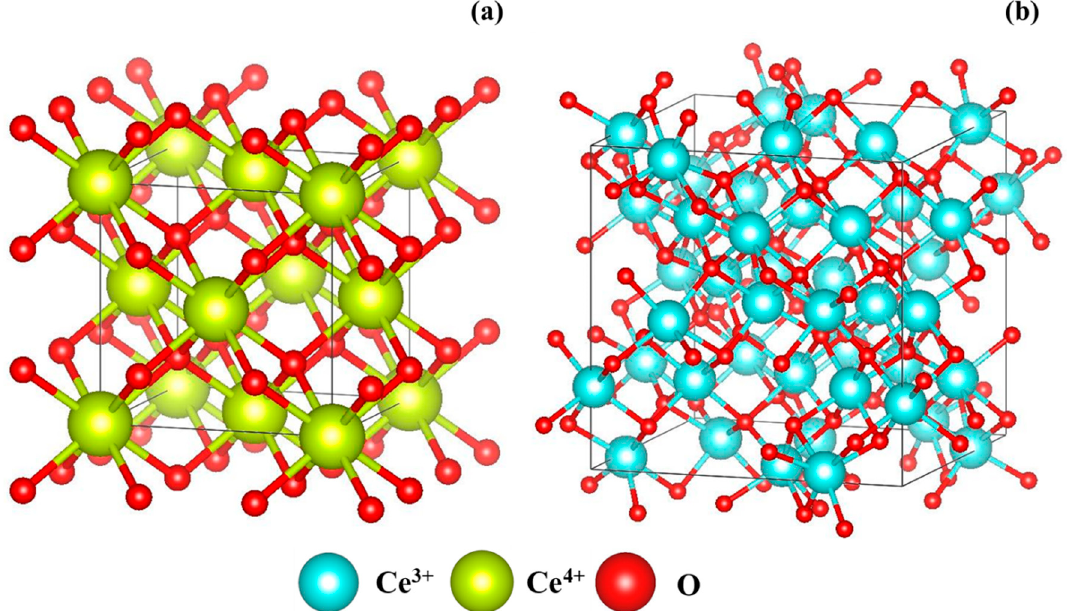
Figure 4. Lattice unit cells for ( a ) tetravalent cerium oxide and ( b ) C-type structure of trivalent cerium [44].